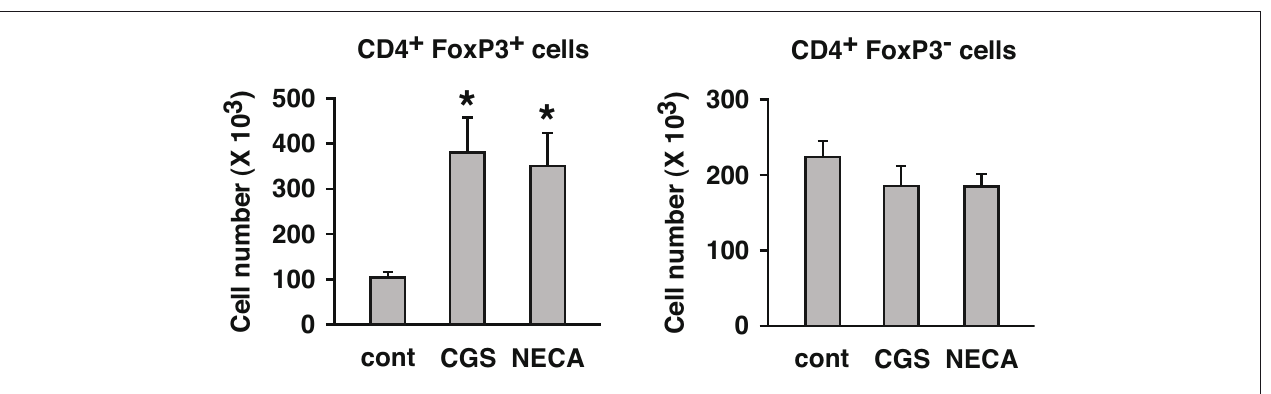
FIGURE 6 | Numerical increase of Treg after T cell activation in the presence of A2AR agonists. MLC was set up in the absence of CD8 + cells. Two days after restimulation (7 days after initial stimulation), total live cells were enumerated under a microscope. Numbers of H-2K b + CD4 + FoxP3 + and H-2K b + CD4 + FoxP3 − cells were estimated